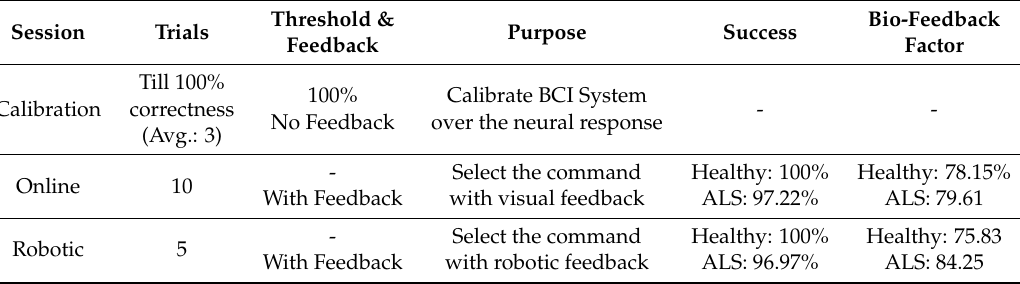
Table 5. Experiment sessions used in